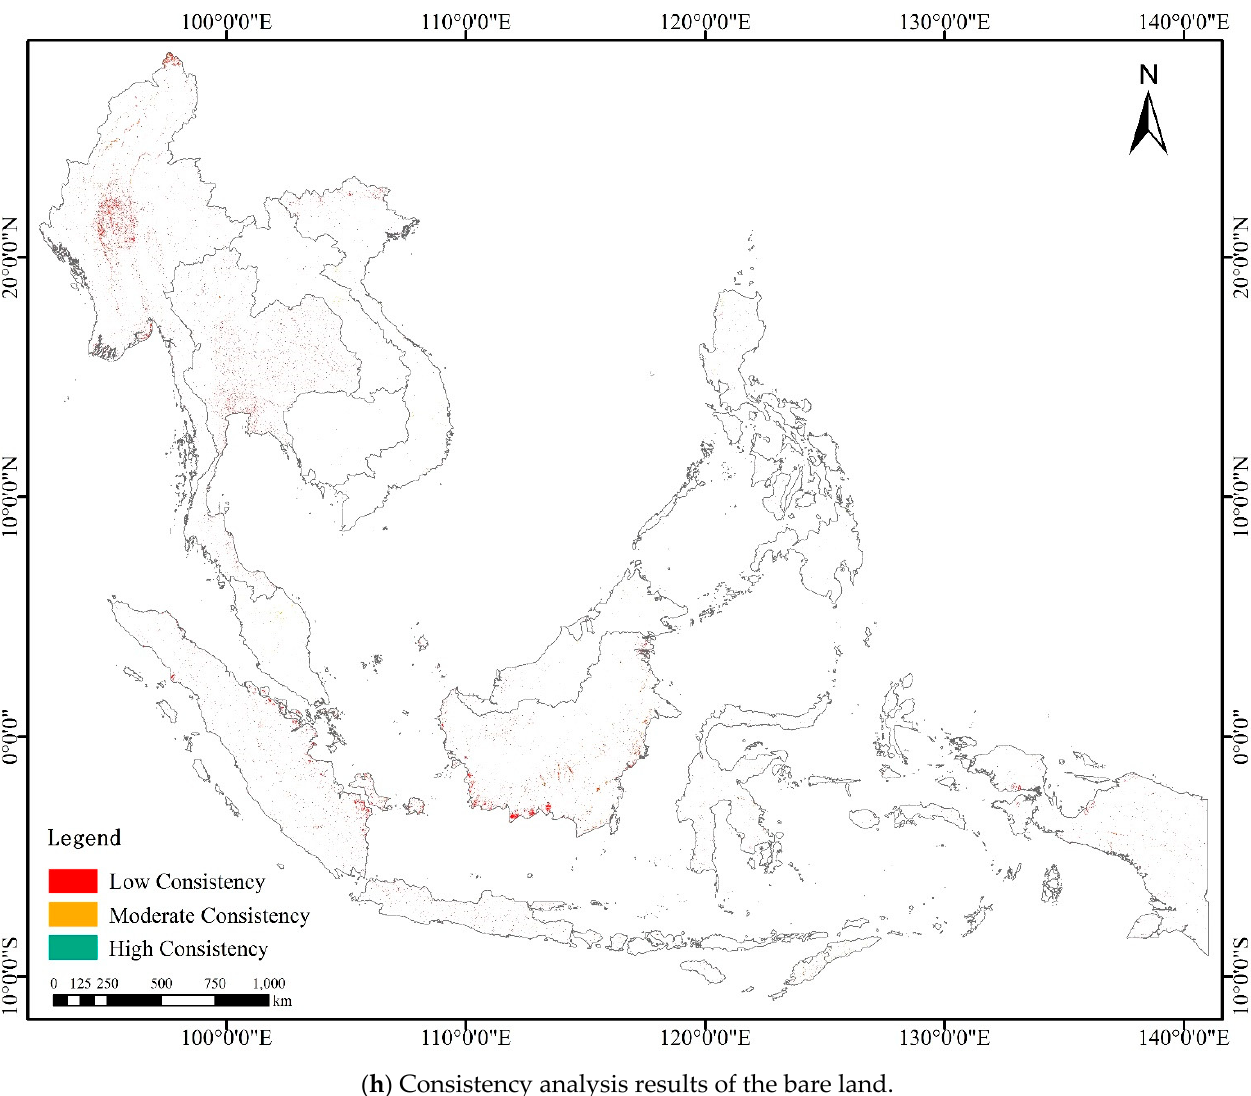
Figure A1. Consistency analysis results for the eight classes: cropland, forest, grassland, shrubland, wetland, water, built-up area, and bare land.